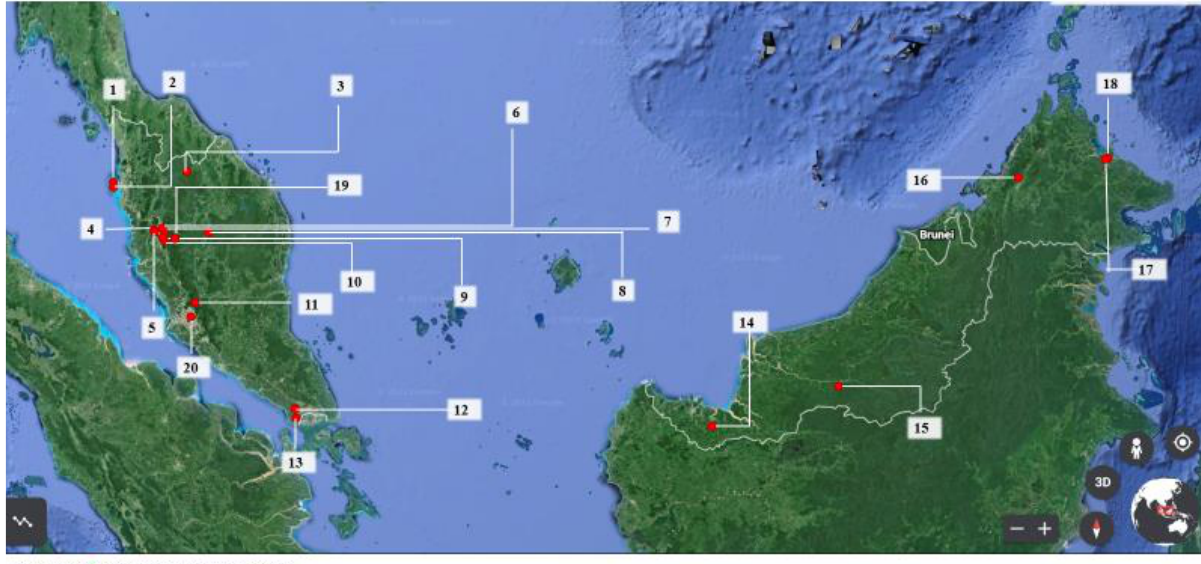
Figure 1. Location of sediment-related disaster events (involving death) in Malaysia.